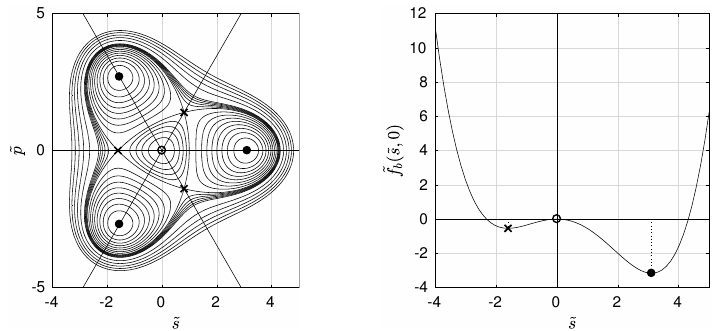
√ √ 6 s , ˜ p = 2 p . ±√ 3 ˜ s (where it is uniaxial).